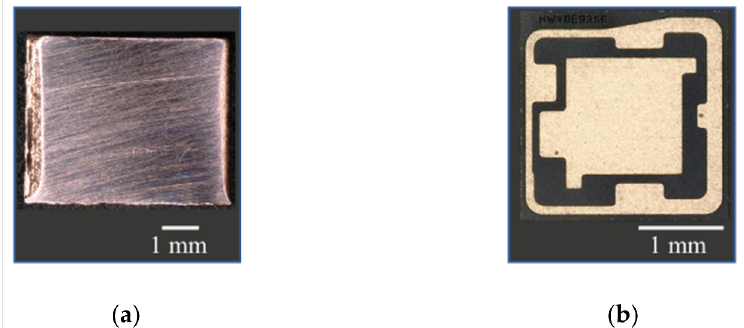
Figure 1. Schematic illustration of an assembled device showing three main components: Si chip on top, substrate on bottom, and interconnection material in between. The cartesian axis system reflects the geometric symmetry of the Si crystal.